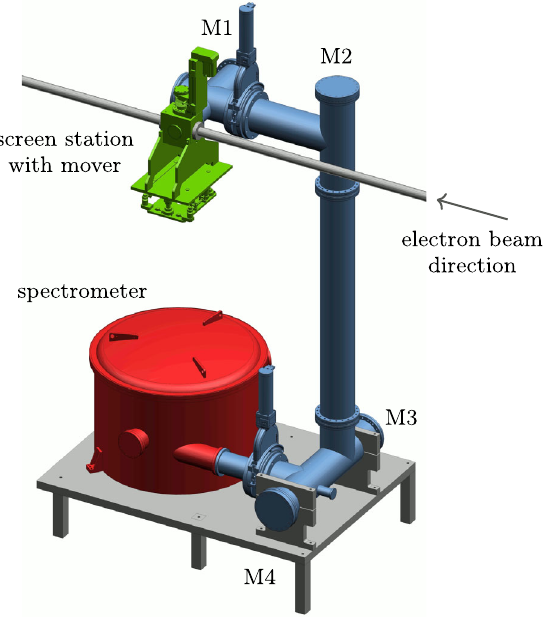
FIG. 4. 3D model of the experimental setup for CDR spec- troscopy. The electron beam coming from the right passes through the screen station (green) where it emits CDR. The CDR is guided by four gold-coated mirrors (M1-M4) through the CDR beamline (blue) down into the spectrometer